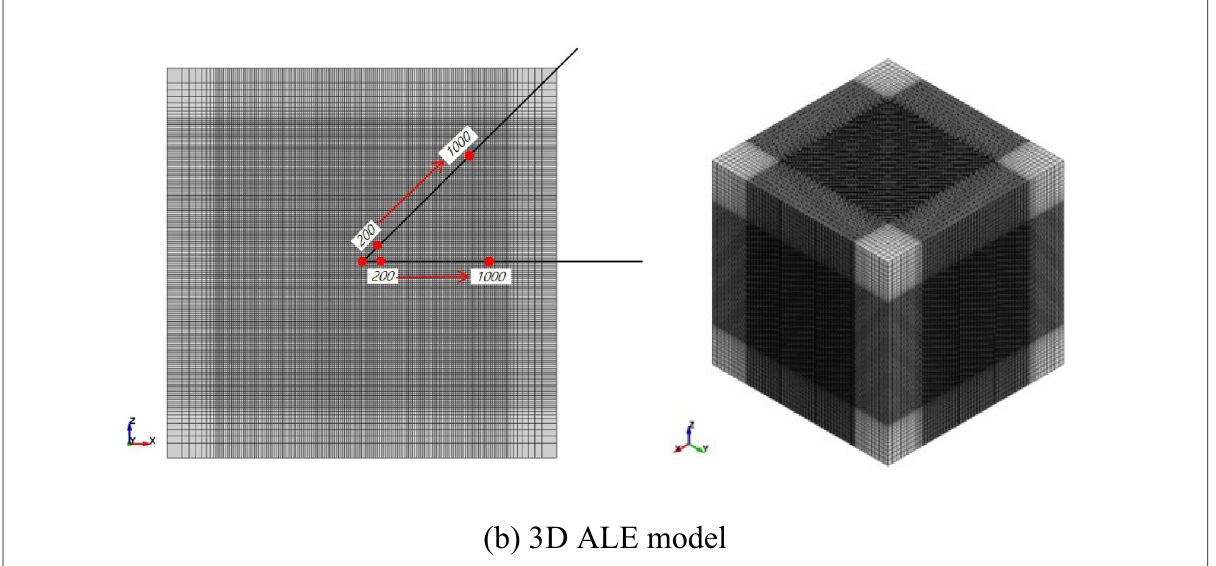
Fig. 13 ALE mapping reliability review